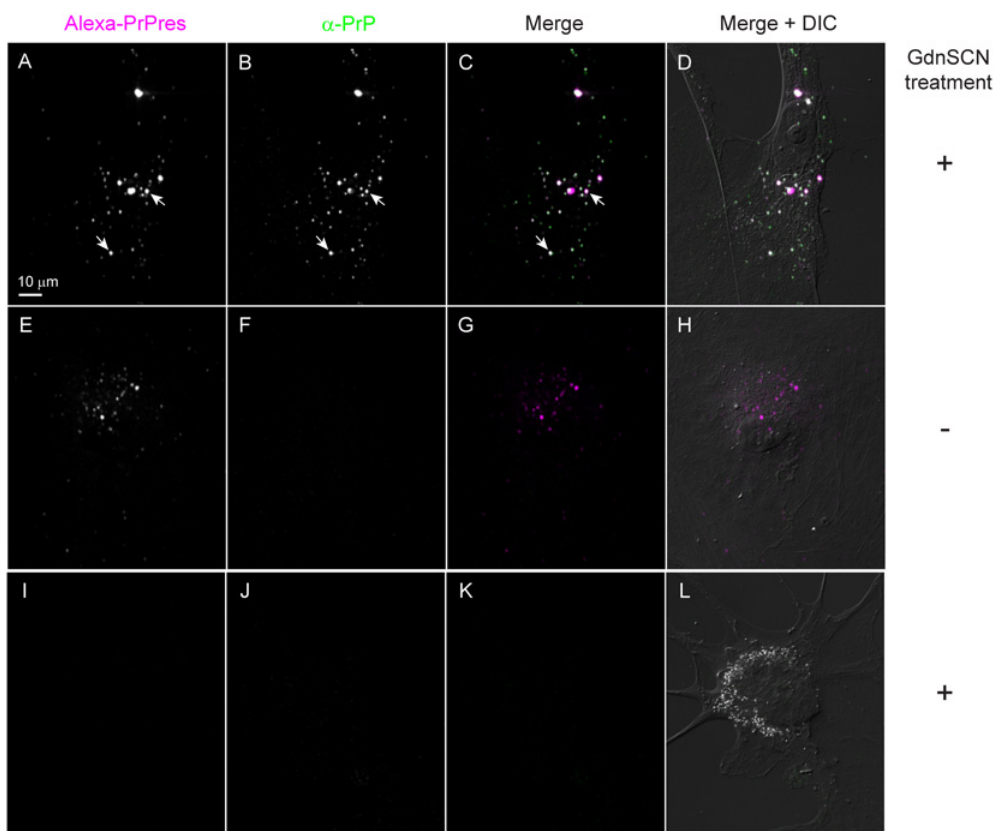
Fig 9. Fluorescent particles internalized by non-neuronal cells are PrPres. Non-neuronal cultures were treated with 263K A647 for 2 days and then subjected to PrPres-specific immunostaining with anti-PrP mAb 132. Internalized fluorescent aggregates (A and E) were specifically labeled with mAb 132 only when the samples were treated with GdnSCN (compare B to F). A negative control culture (I-L) treated with GdnSCN but not 263K A647 showed no fluorescence in the Alexa Fluor 647 channel (I) or immunostaining with mAb 132 (J). A merge of the Alexa-PrPres (magenta) and mAb 132 (green) channels is presented with (D, H and L) and without (C, G and K) an overlaid DIC image for each field of view. Merge, white indicates co-localization with equal signal from each